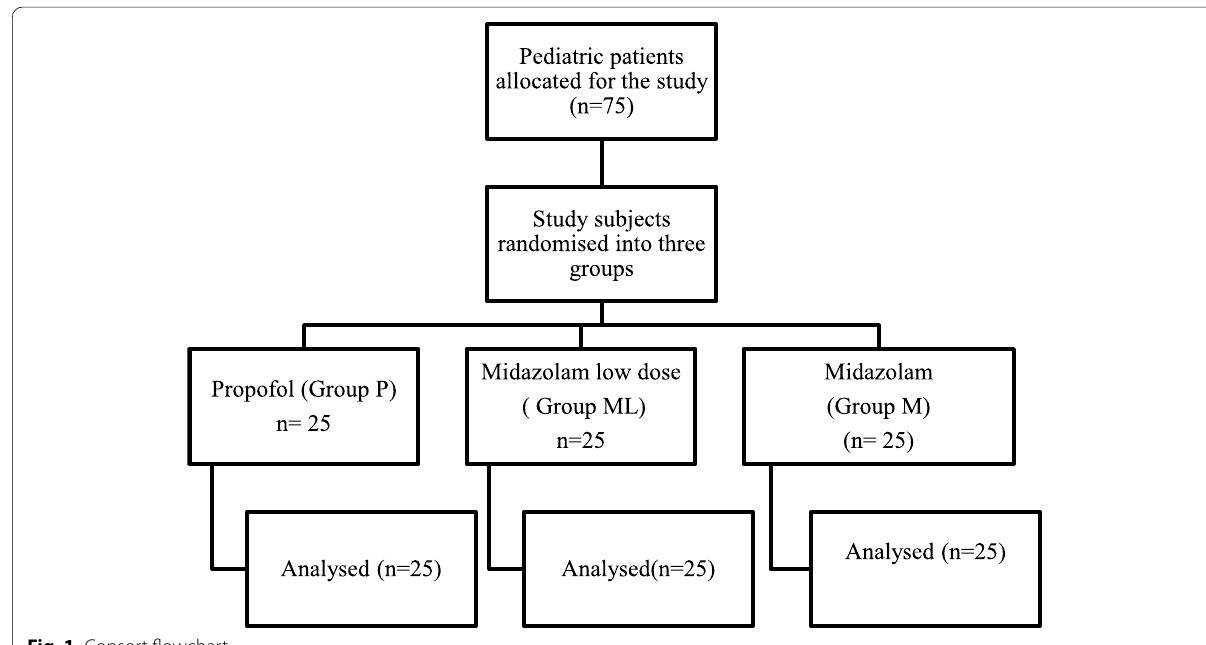
intergroup comparison of the incidence of ED between group P and group ML ( p 0.04) and comparison = between group P and group M ( p 0.02) was found to be = statistically significant. There was no statistically signifi- cant difference between the incidence of ED in group M and ML ( p 0.747). = Cole’s score at 10 min, 20 min, and 30 min postoper- atively were significantly less ( p <0.001) in group M and group ML compared to group P. The difference was not statistically significant at 45 min, 1 h, and 2 h (Tables 4